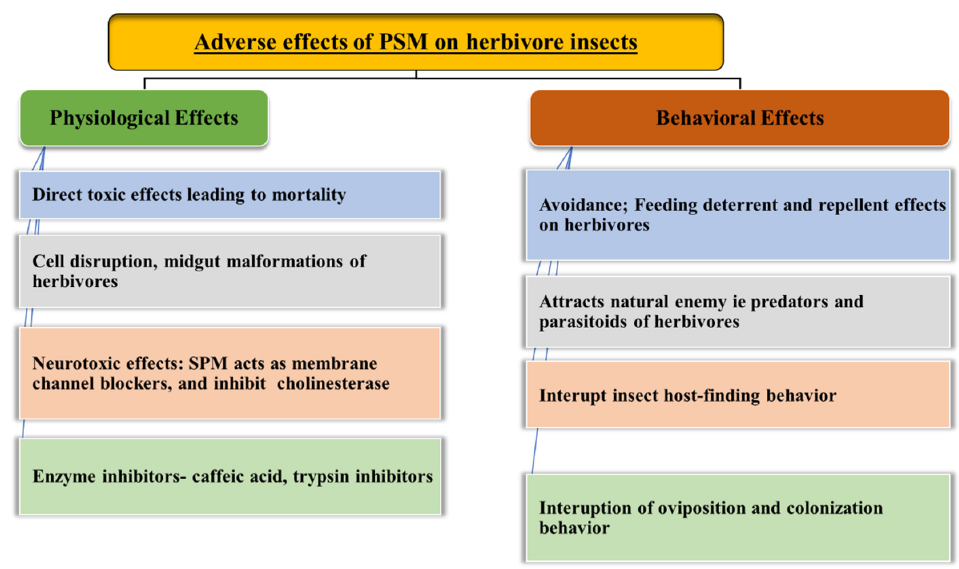
Figure 3. Adverse effects of PSM on the physiology and behavior of herbivores.